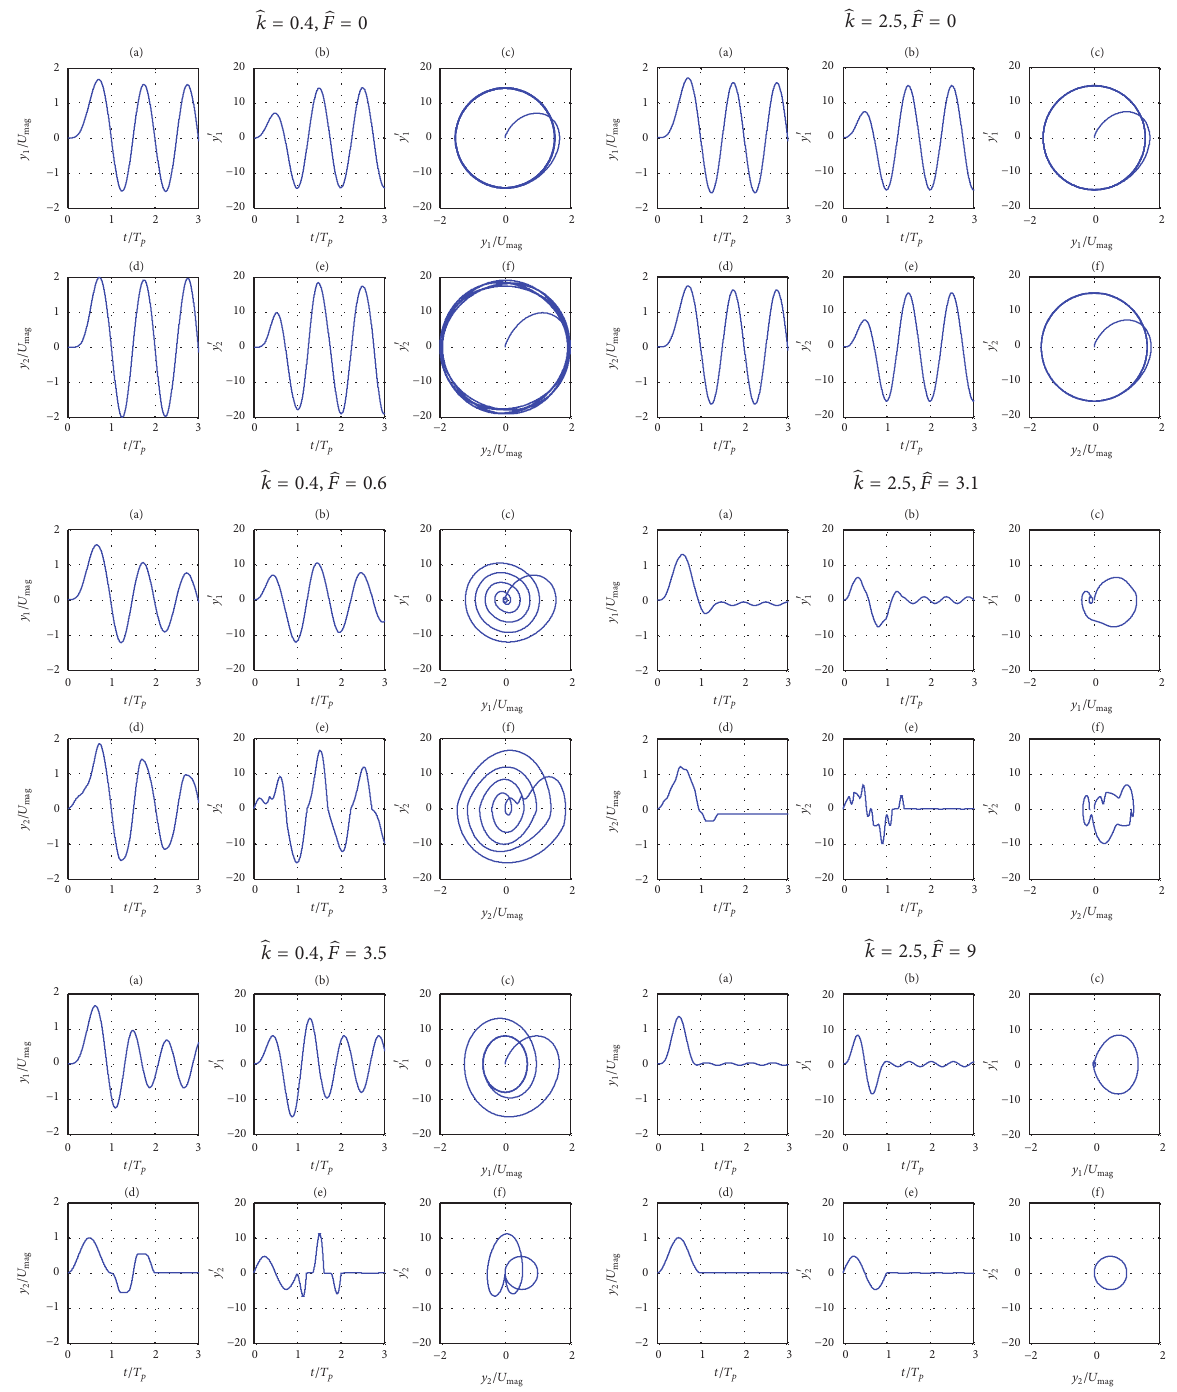
̂𝑘 = 0.4 ) and medium (frequency